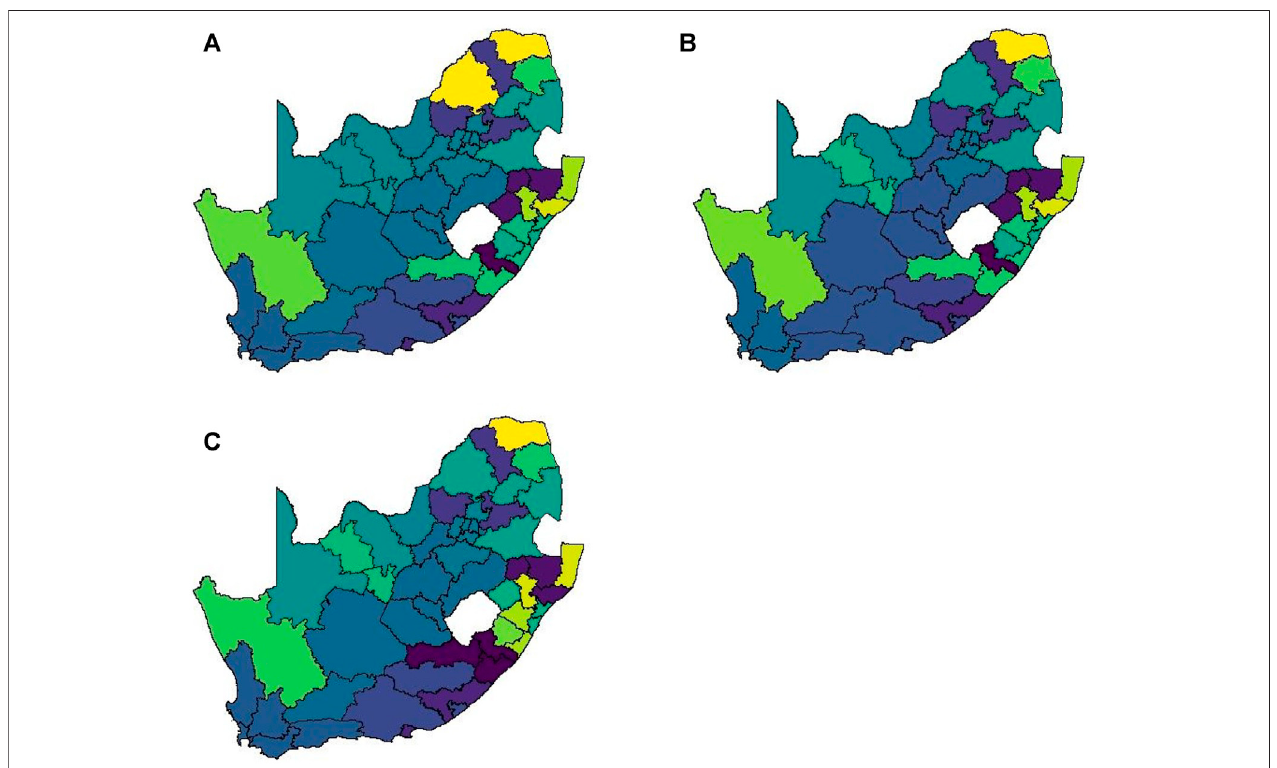
FIGURE 8 | Method 2 complete linkage clustering results (20 clusters) (A) Business as usual, (B) Level 5 and (C) Level 4.